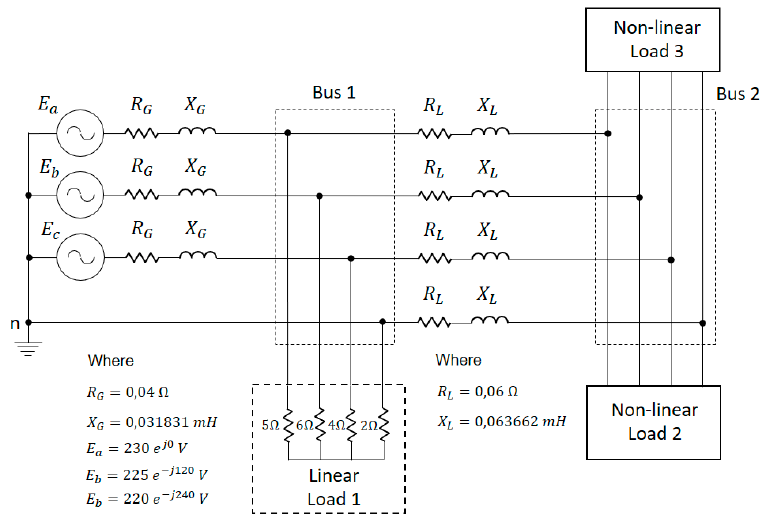
Figure 4. Three-phase electrical system with non-linear loads.